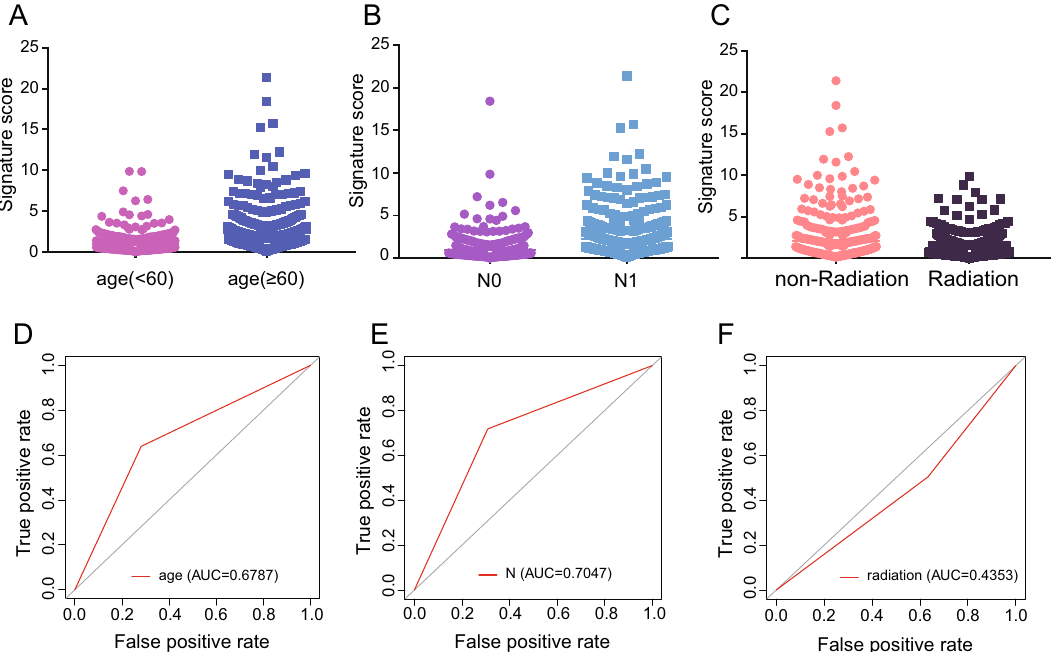
Figure 9. The accuracy of the breast cancer risk model constructed by prognostic related genes in clinicopathological indicators and prognosis (N0 indicates no lymph node metastasis and N1 lymph node metastasis). ( A – C ) Correlation between the risk score and clinical factors (AGE < 60 vs AGE > 60; N0 vs N1; Non-radiation vs Radiation). ( D – F ) Prognostic accuracy of risk scoring.